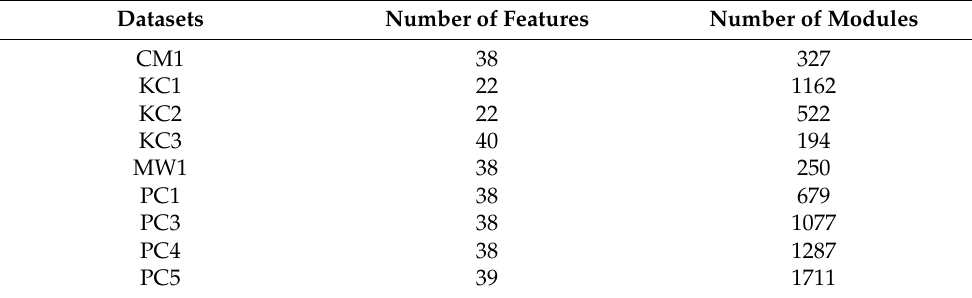
Table 3. Description of selected NASA